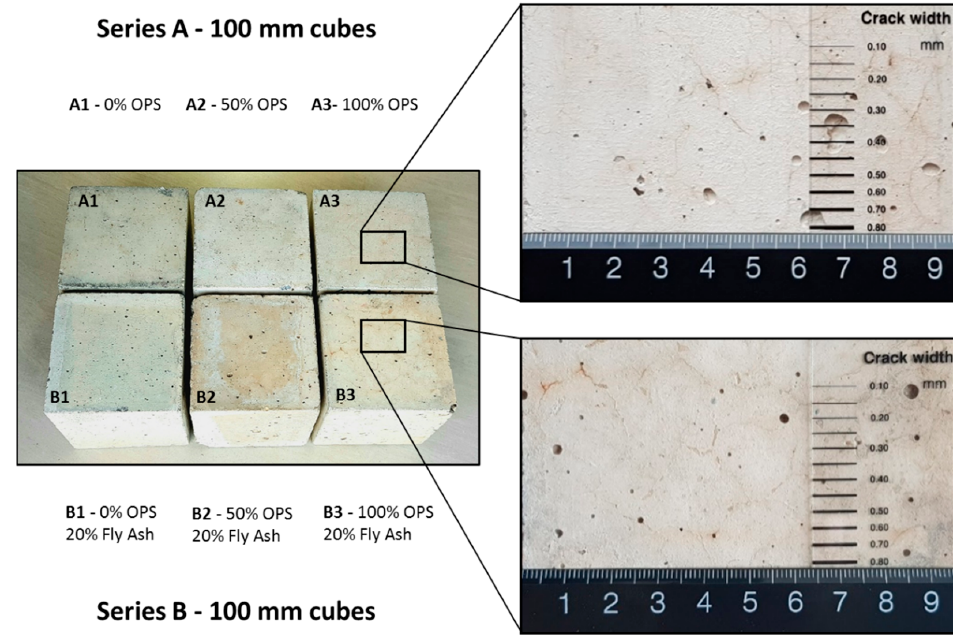
Figure 13. Drying shrinkage cracks on the surface of specimens with 100% OPS.